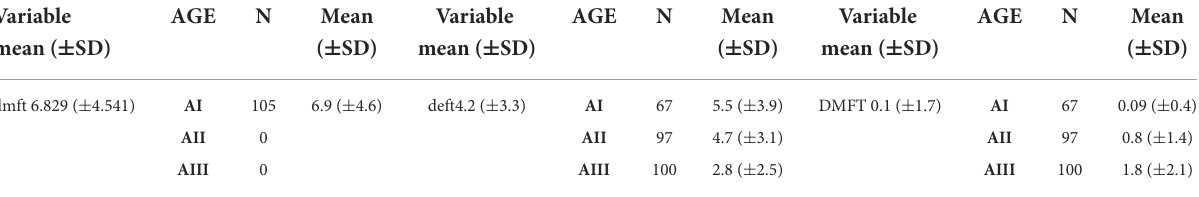
TABLE 3 Mean ( ± SD) of dmft, deft, and DMFT indices.